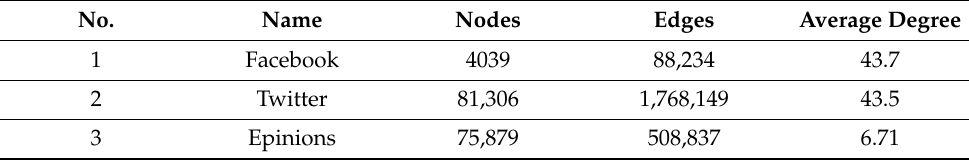
Table 1. Dataset